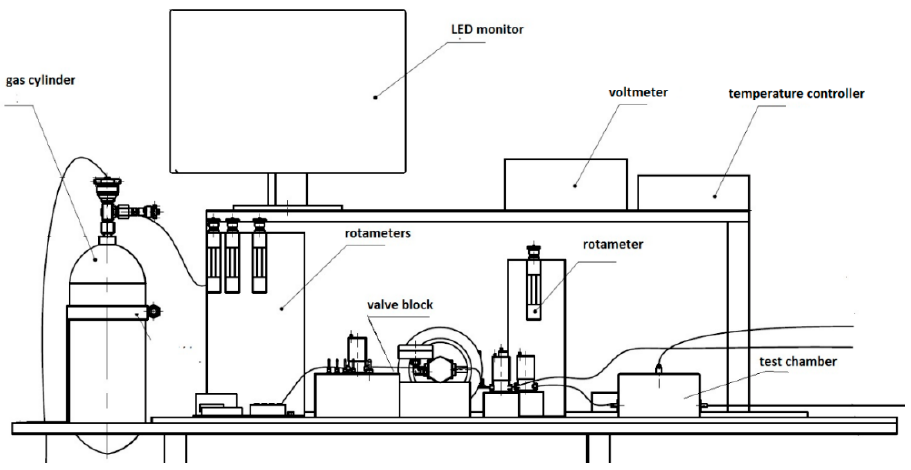
Figure 2. Schematic diagram of the measurement setup. LED = light-emitting diode.